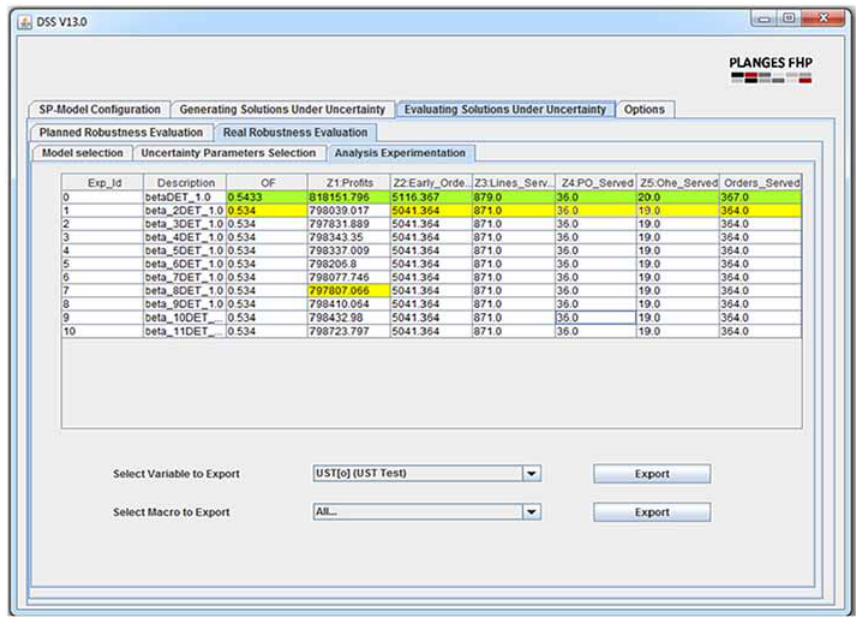
Fig. 10. The “Analysis Experimentation” option for the “Real Robustness Evaluation” DSS